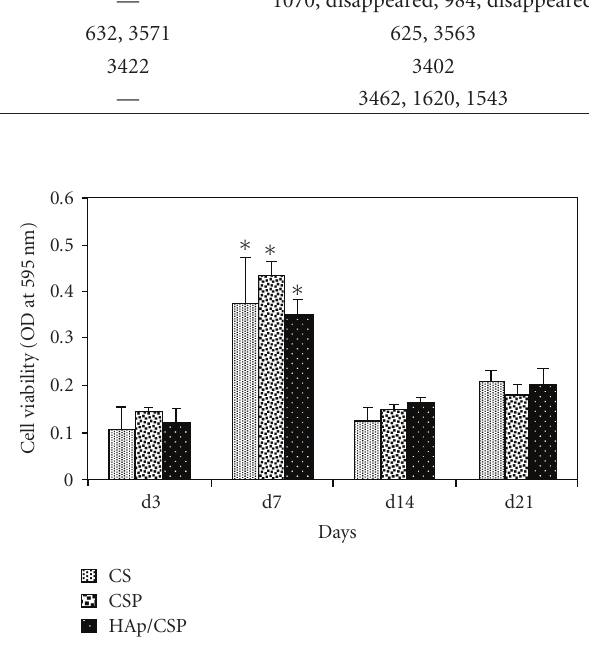
Figure 6: Osteoblast cell proliferation on CSP and HAp/CSP films, CS was taken as control. Significant increase in cell number ( P < . 001) was found at day 7 in all the variations followed by retardation of growth